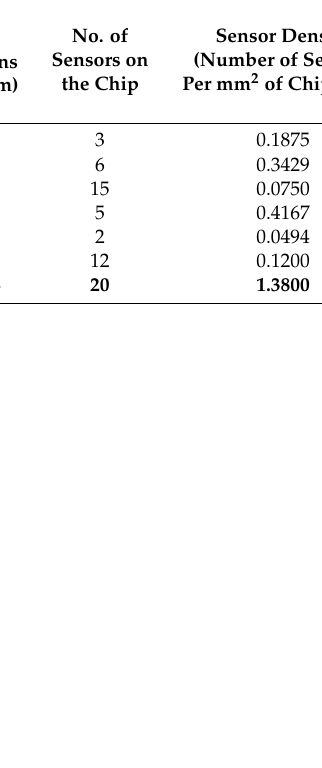
Figure 14. Response of the aluminium-based flow rate sensor in the multi-sensor SOI CMOS MEMS chip. A constant current of 40 mA was used to heat the embedded metal film.